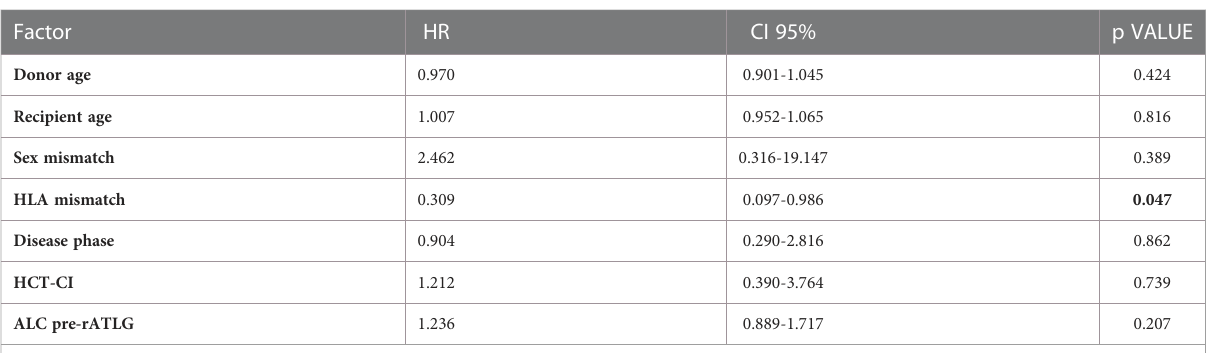
TABLE 2 Multivariate